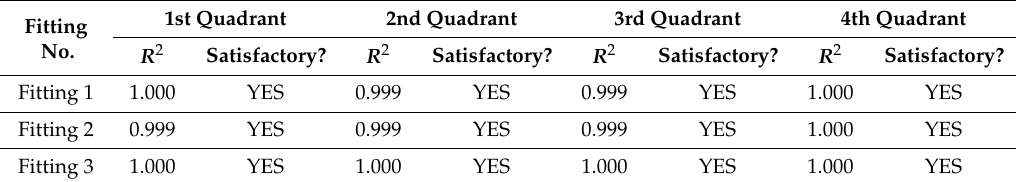
Table 8. Goodness of fit for the case of the intact hull.